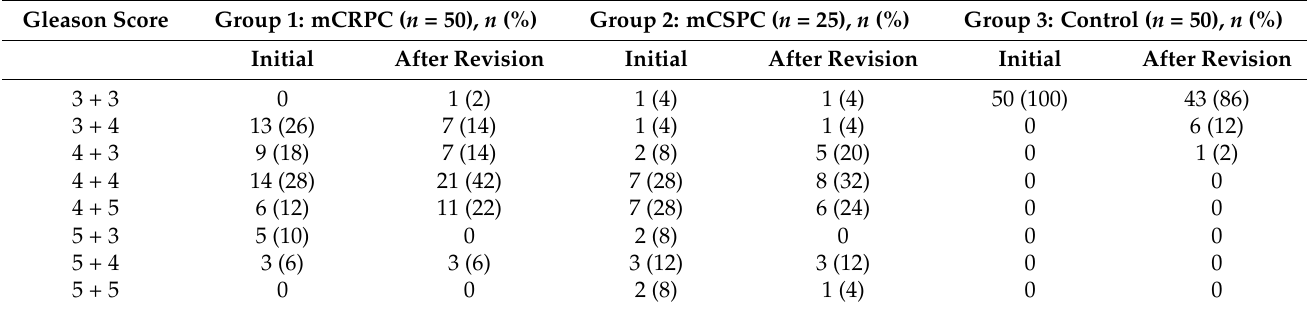
Table 2. Variations in Gleason Score.